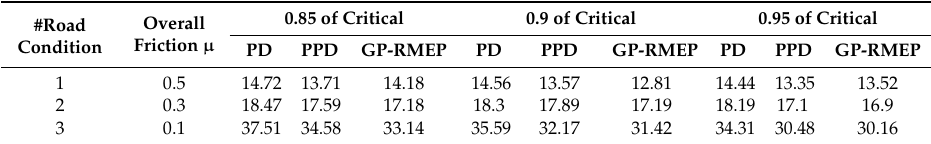
Table 6. Times needed to return to the lane center,